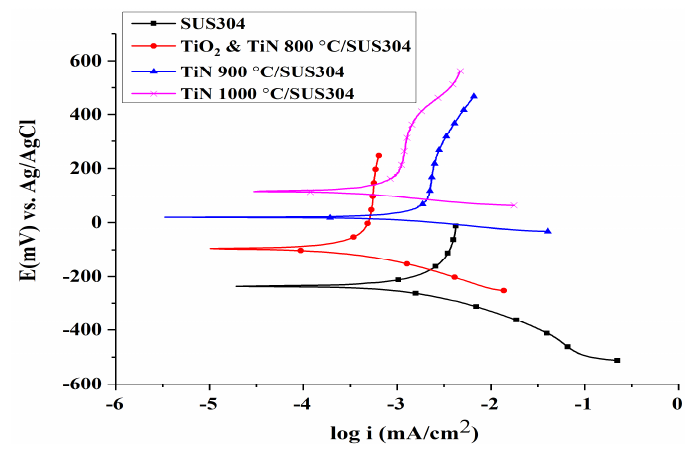
Figure 3. Tafel curves for coated and uncoated SUS304 cathodes in an EF system. Note: The solution contains 0.1 M KNO 3 and 20 ppm of Fe 2+ . The pH value of the solution was adjusted to pH = 3 using 1 M HNO 3 . Table 3. Tafel properties of coated and uncoated SUS304 electrodes in an EF system.